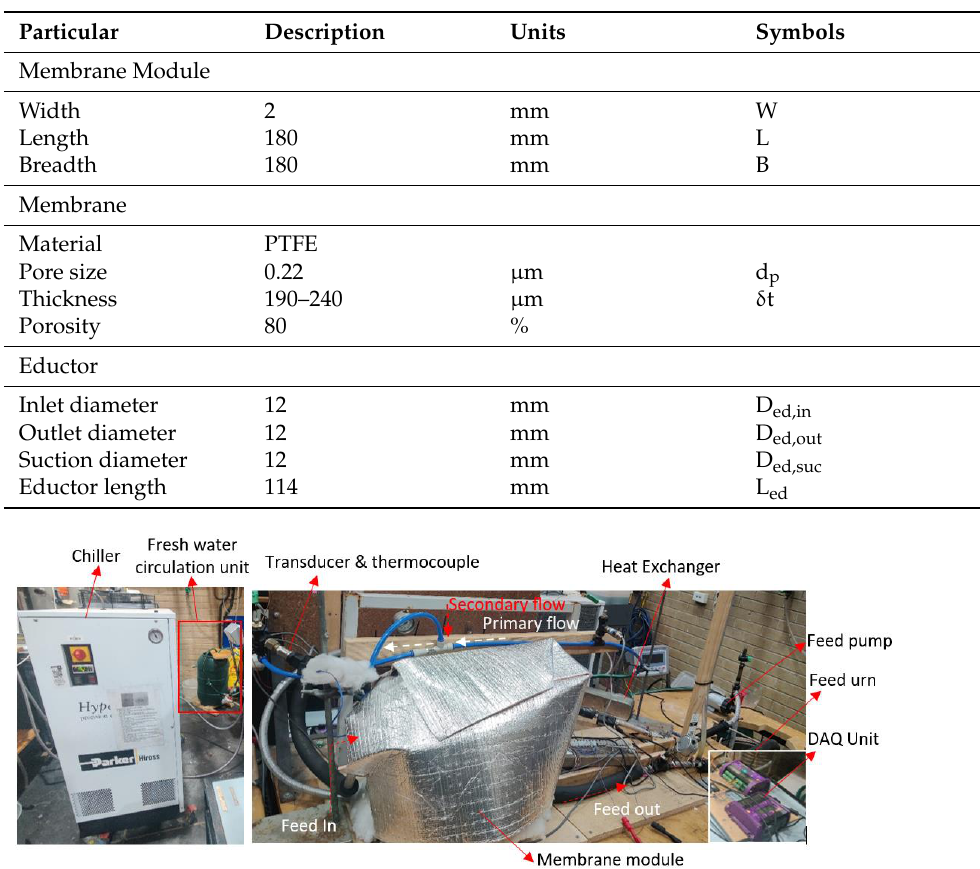
Figure 5. Experimental setup of the module. Table 3. Physical properties of membrane module, membrane, and eductor.